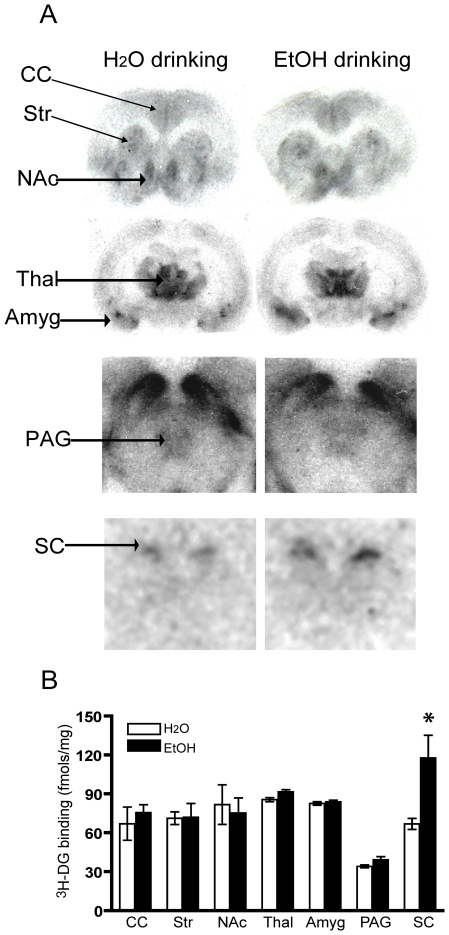
Comparison of MOR density in the CNS after 8 weeks of drinking.(A) Representative autoradiograms showing [3H]DAMGO binding in coronal sections from water and ethanol drinking rats. (B) Histograms show the quantification of MOR binding from different CNS regions of ethanol and water drinking rats. Results are expressed as the mean ± SEM value from 3–4 rats in each group with 4–6 sections for each rat. * p<0.05, compared with water drinking group. CC  =  Cingulate cortex; Str  =  striatum; NAc  =  nucleus accumbens; Thal.  =  thalamus; Amyg.  =  amygdala; PAG  =  periaqueductal gray; SC  =  spinal cord.